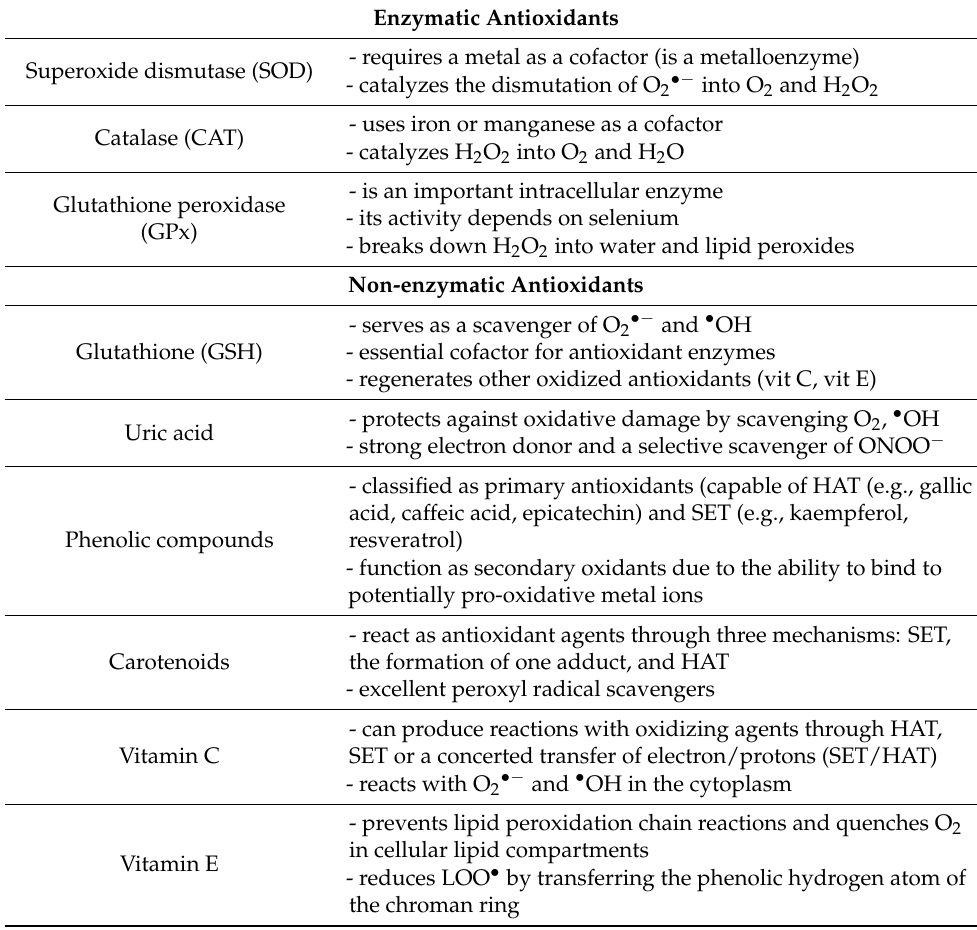
Table 1. Mechanisms of action of selected enzymatic and non-enzymatic antioxidants [12,13,17,19]. Enzymatic